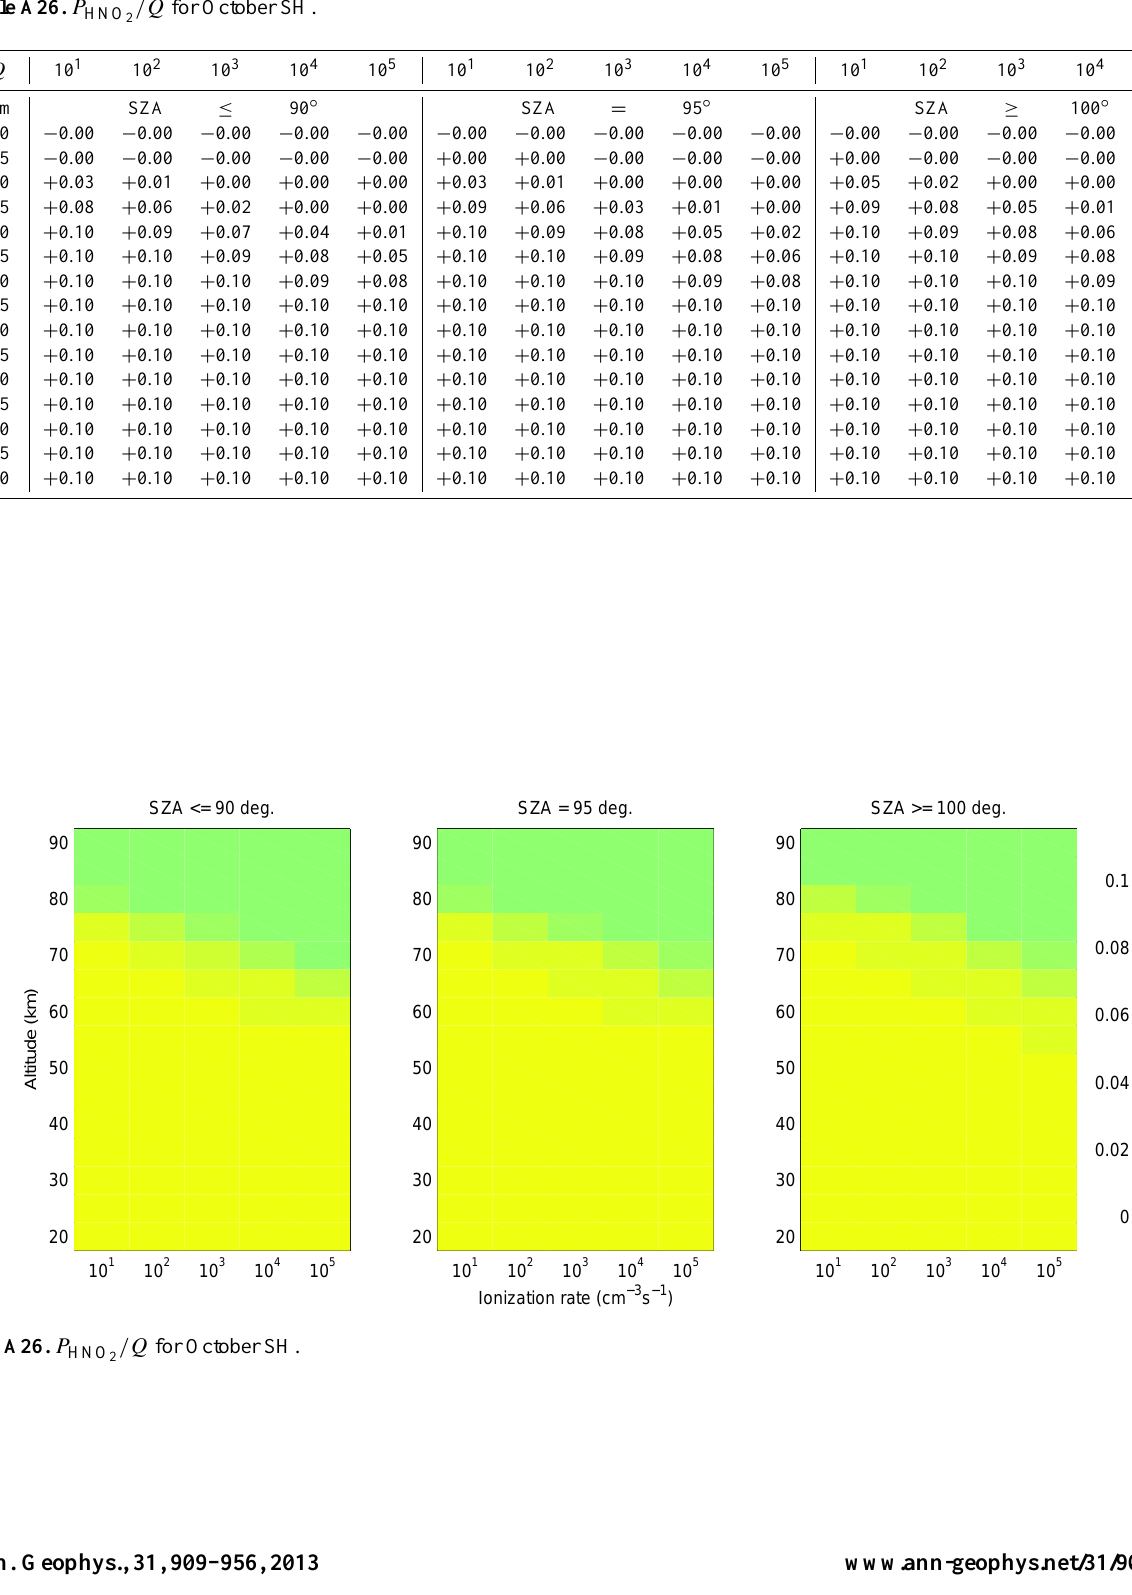
Table A26. P HNO